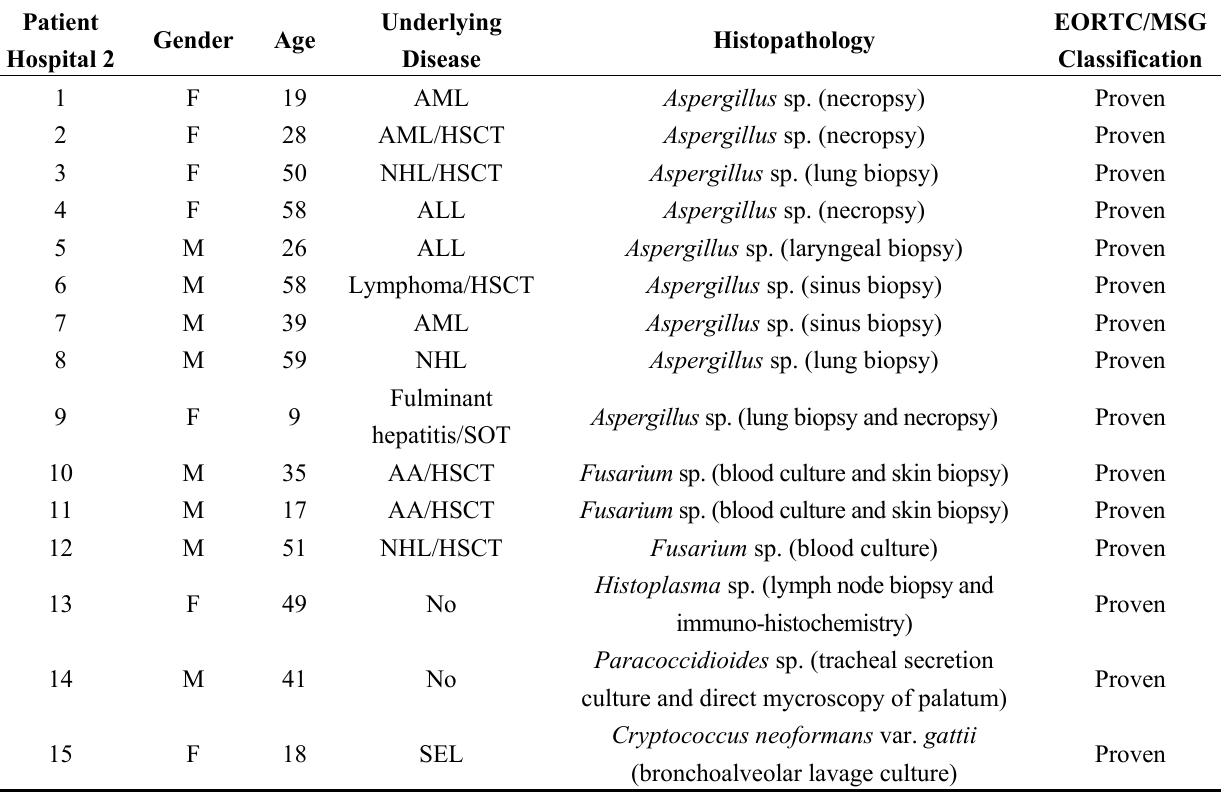
Table 5. Additional information about patients from Hospital